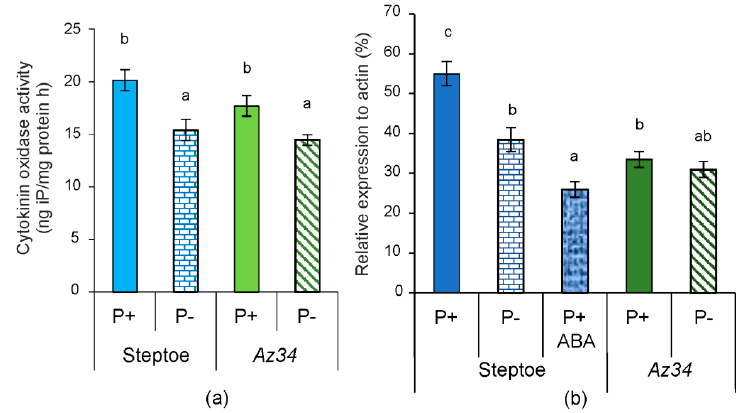
Figure 10. Cytokinin oxidase activity ( a ) and HvIPT1 transcript abundance ( b ) in root tips of 4-days-old barley seedlings (Steptoe and Az34 genotypes) grown for 1 day on the nutrient solutions with (P+) or without (P − ) phosphate. ABA was added to the nutrient solution one day prior to sampling (P+ ABA). Data are the mean of five determinations, with different letters above the bars indicating significant ( p < 0.05) differences according to ANOVA (LSD).